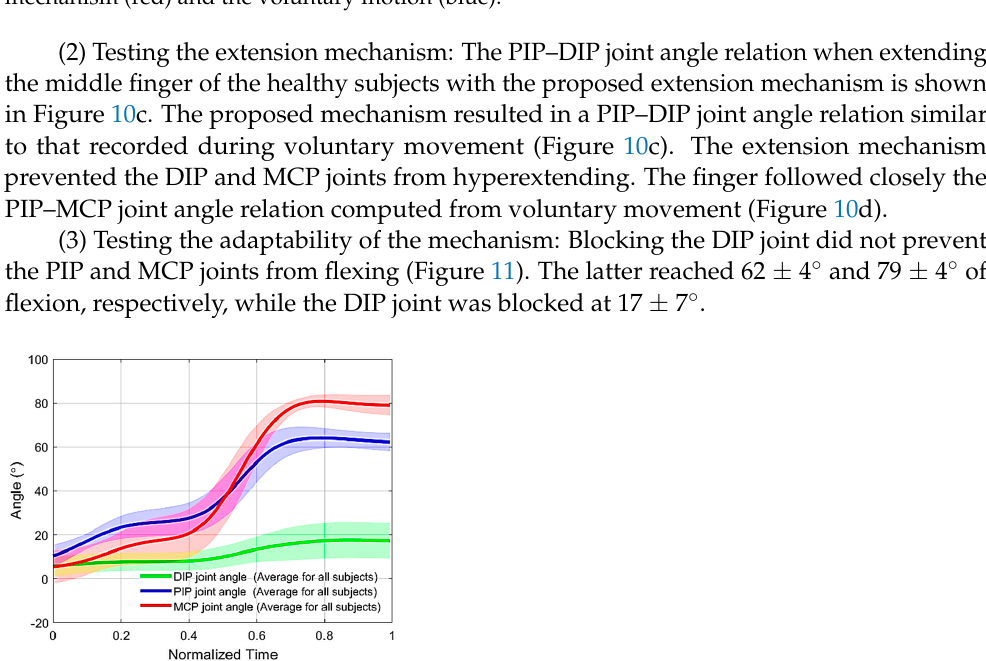
Figure 11. DIP, PIP, and MCP joint flexion trajectories for the middle finger of healthy subjects flexed using the proposed mechanism after blocking the DIP joint with a finger splint. The thick lines are the means, and the shaded areas represent the standard deviation.